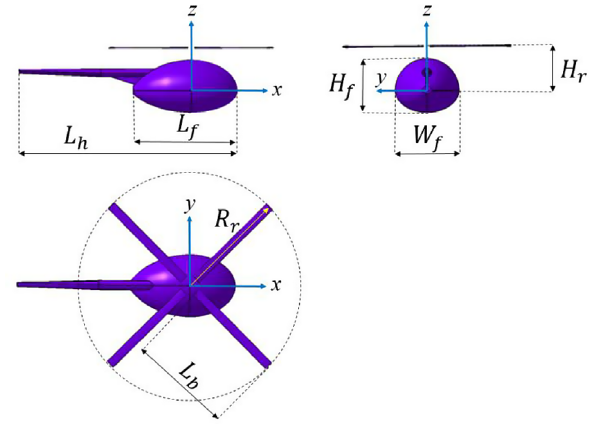
Figure 1. Establishment of the simpli fi ed helicopter geometry model (including rotor and fuselage). Table 1. Nomenclature of the physical quantities.